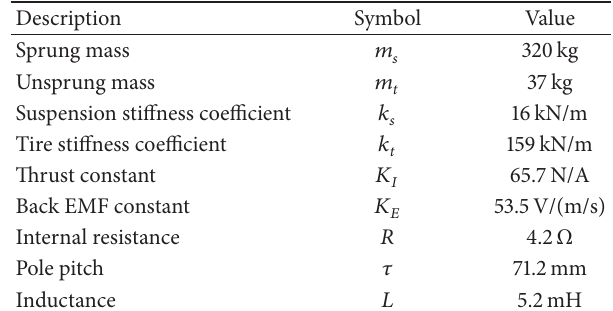
Table 5: Parameter of model.